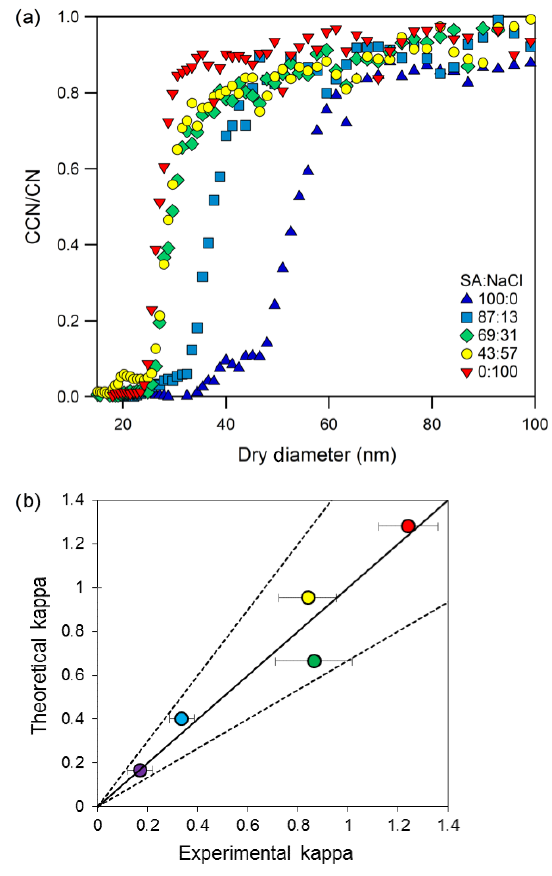
Figure 3. (a) Activation curves for two-component internal mix- tures of NaCl and succinic acid (SA) at SS 0.72%. Doubly charged aerosols are present but are all below 0.1 and negligible. (b) In- ternally mixed aerosols. Multicomponent hygroscopicity parameter predictions vs. experimentally derived kappa values. Dashed lines indicate 50% uncertainty (1 : 1 . 5 and 1 . 5 : 1). Data are within 20% uncertainty of the 1 : 1